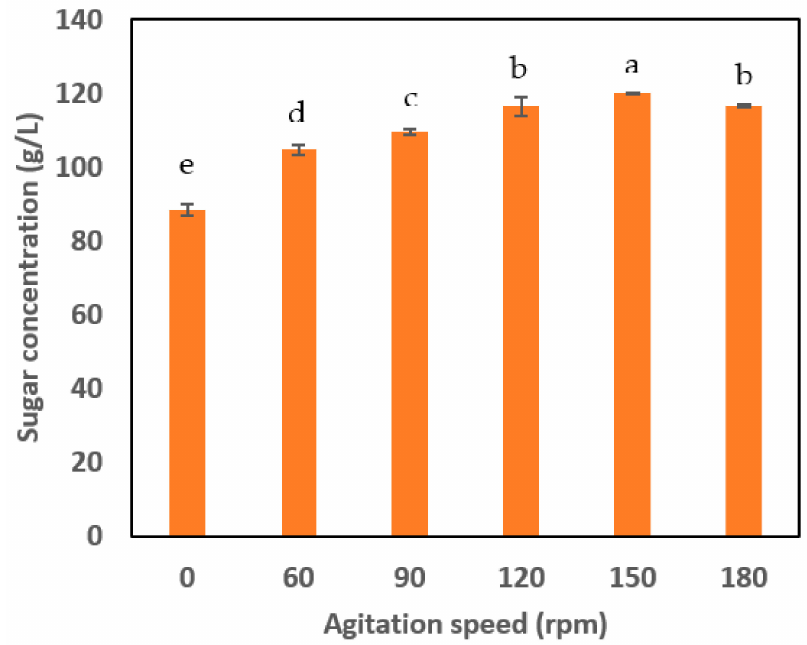
Figure 5. Effect of agitation speed on the saccharification process. All data are the means of 3 replicates ± S.D. The different alphabet indicates significant difference at p < 0.05. The data were stated using LSD